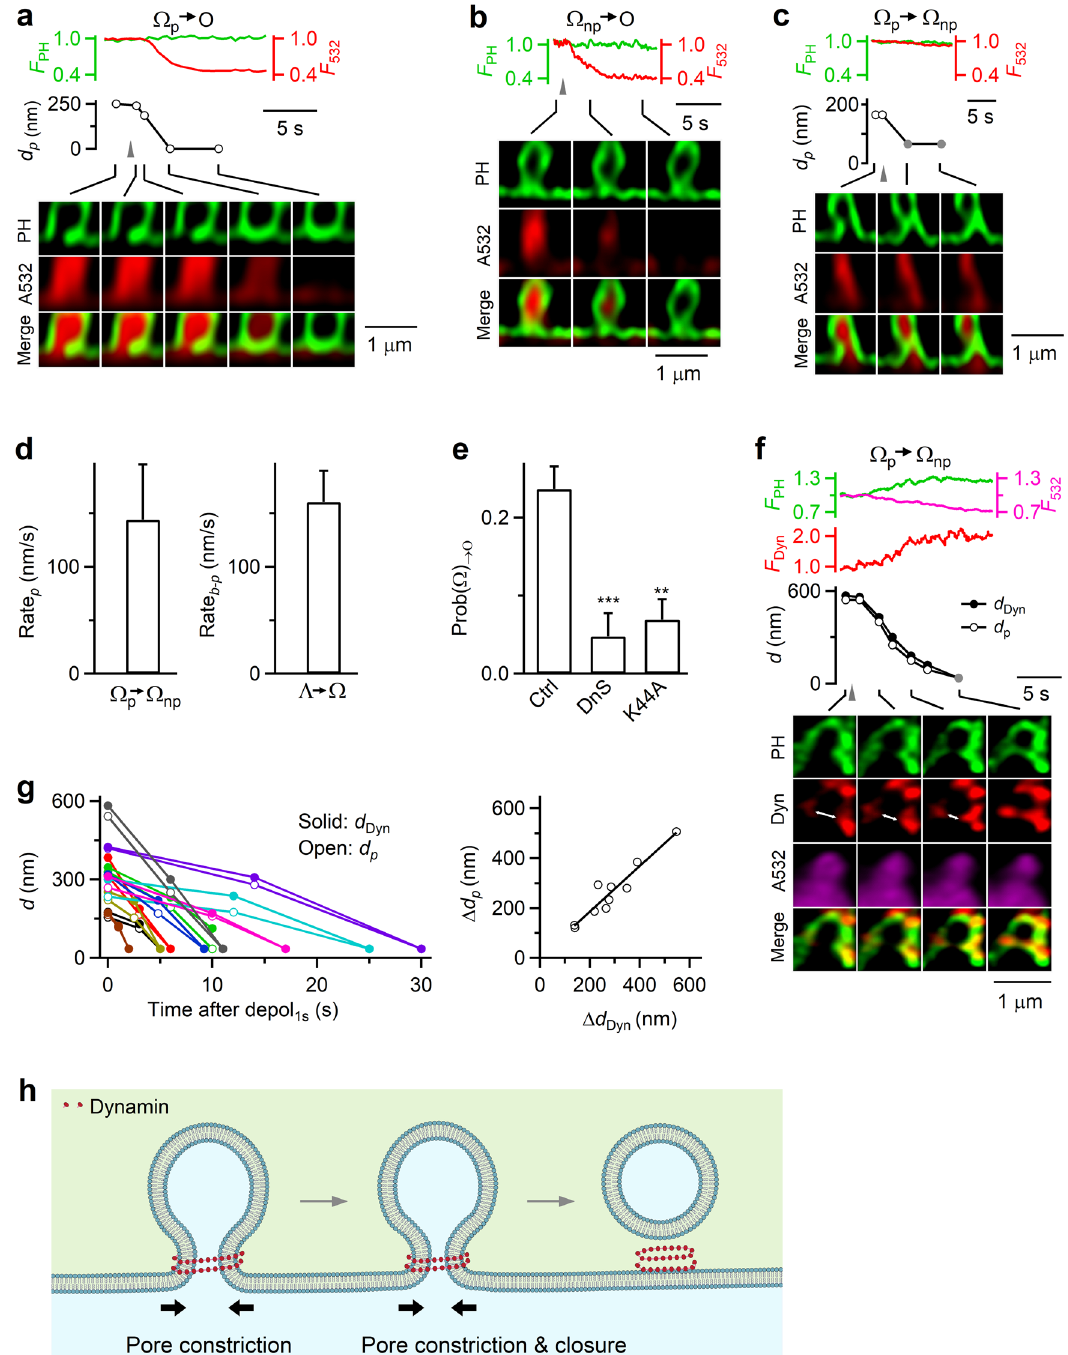
Fig. 6 Dynamin mediates Ω → Ο by surrounding and constricting Ω ’ s pore. a F PH , F 532 , Ω ’ s pore diameter (d p ), and XZ/Y fi x images showing Ω p → O. Gray triangle: depol 1s . b F PH , F 532 , and XZ/Y fi x images showing Ω np → O. c F PH , F 532 , Ω ’ s pore diameter (d p ), and XZ/Y fi x images showing Ω ’ s pore constriction from visible to non-visible pore ( Ω p → Ω np ). Gray triangle: depol 1s . gray circle: <60 nm. d The rate of pore size decrease during Ω p → Ω np (Rate p , 20 – 80%, n = 13) and the rate of d b-p decrease during Λ → Ω (Rate – 80%, n = 22) are similar. Data are presented as mean + SEM. e Inhibition of dynamin b-p , 20 reduces Ω → Ο transition: Prob( Ω ) → Ο in control (Ctrl, 513 cells from 168 cultures; 336 bovines), in the presence of dynasore (DnS, 64 cells from 13 cultures; 26 bovines; p = 0.0009) or with overexpressed dynamin 1-K44A (Dyn-K44A, 106 cells from 21 cultures; 42 bovines; p = 0.0018). ** p < 0.01; *** p < 0.001 (two-tailed unpaired t -test, compared to Ctrl). Data are presented as mean + SEM. f Dynamin puncta fl anked and moved with the constricting pore during Ω → Ω Ω ’ s pore size (d fl anking the pore (d p np : F PH , F Dyn , p p ), the distance between two dynamin puncta Dyn , double arrows), and sampled XZ/Y fi x images of PH/dynamin. Gray circles: <60 nm (STED resolution). g Left: Ω ’ s d p and d Dyn plotted versus time after depol 1s during Ω p → Ω np . Each color: one Ω p → Ω np transition. Right: reduction of Ω ’ s d p ( Δ d p ) plotted versus reduction of d Dyn ( Δ d Dyn ) for each Ω p → Ω np transition (each circle: one transition). h Schematic drawing: dynamin mediates Ω → O by surrounding and constricting Ω ’ s pore. Source data are provided as a Source Data fi